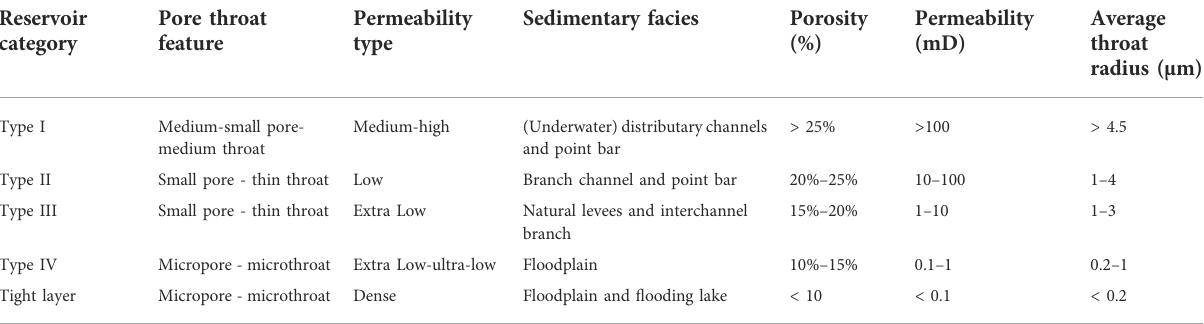
TABLE 2 Statistical results of physical properties of different types of reservoirs in the Quan 3 Member of the Quantou Formation in the study area. Reservoir category